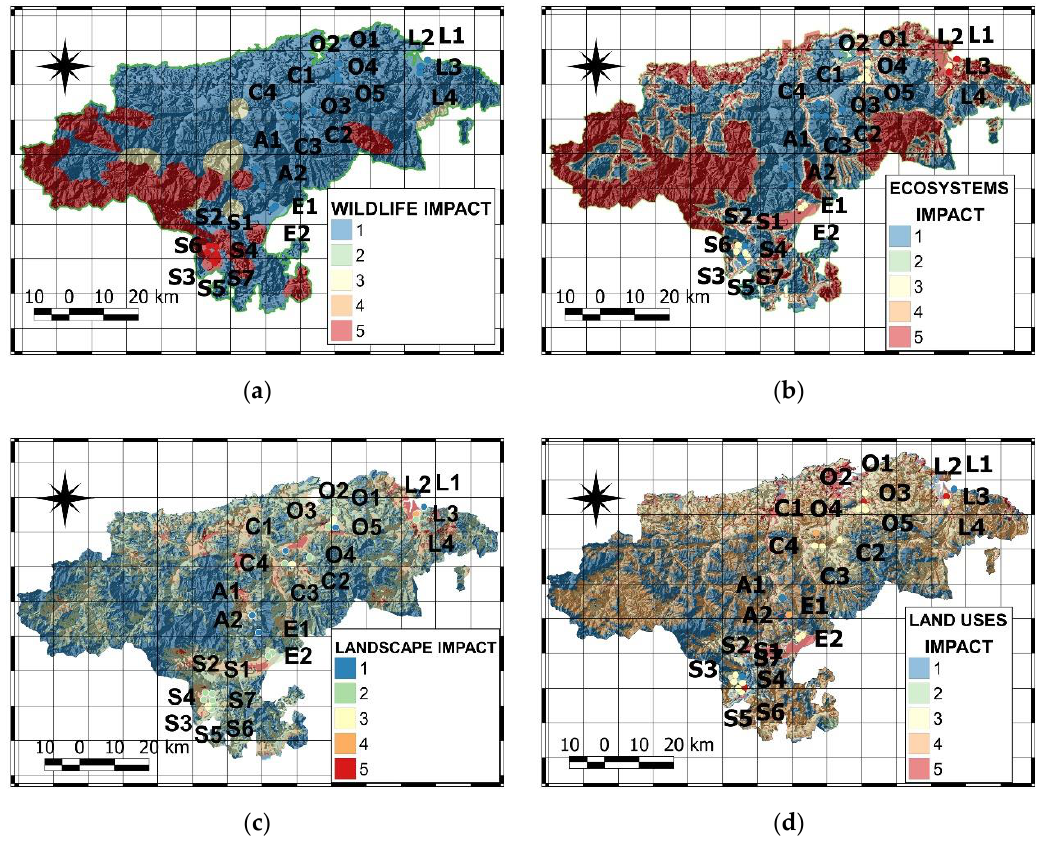
Figure 3. Maps of impacts according to components: ( a ) fauna, ( b ) special ecosystems, ( c ) landscape and ( d ) land uses.